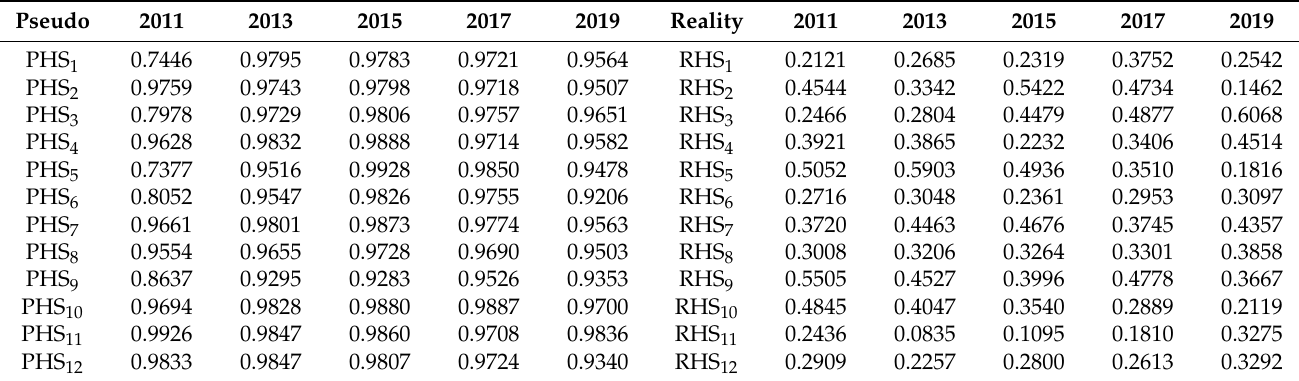
Table 2. The driving forces of urban PHSs and RHSs in 2011–2019.